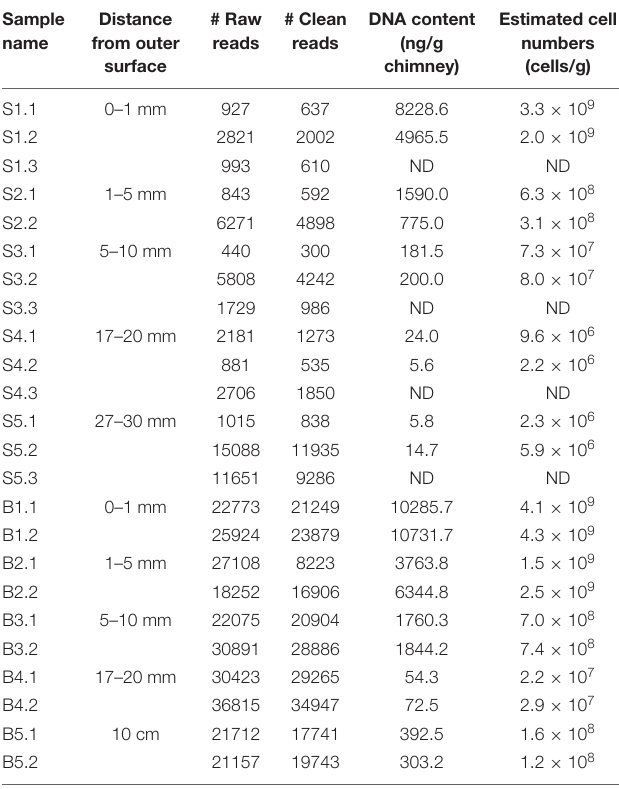
TABLE 1 | List of samples from which 16S rRNA amplicons were obtained.